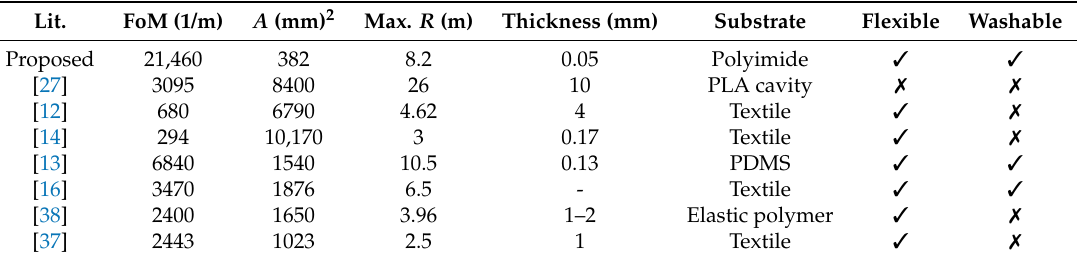
Table 2. Comparison of the proposed RFID antenna with state-of-art RFID antennas. Lit. FoM (1/m) A (mm) 2 Max. R (m) Thickness (mm) Substrate Flexible